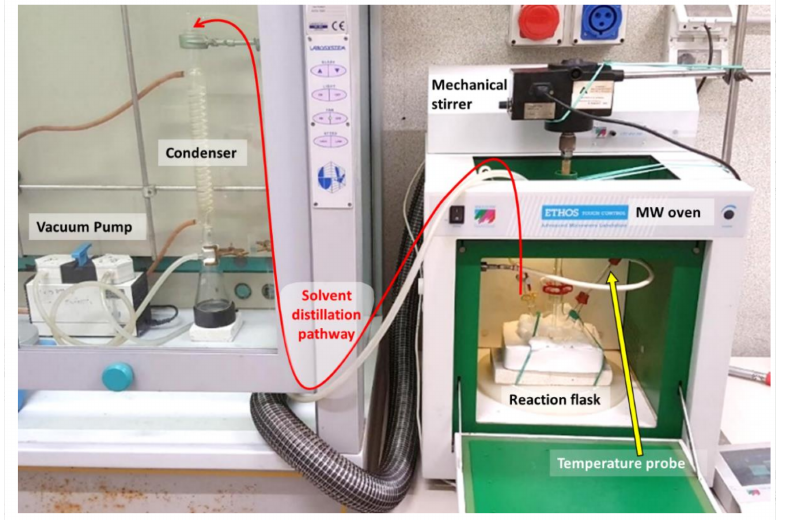
Figure 1. Landscape image of the microwave system modified for solvent distillation from a three- necked flask used in this